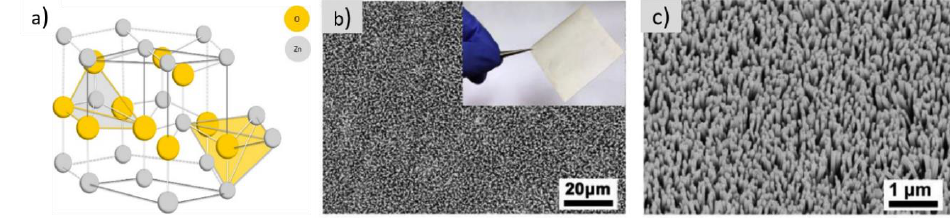
Figure 12. Hexagonal wurtzite crystal structure of ZnO ( a ) and ZnO nanorods grown on nylon fabric ( b , c ). Reprinted with permission from [98]. Copyrights 2019 Elsevier.